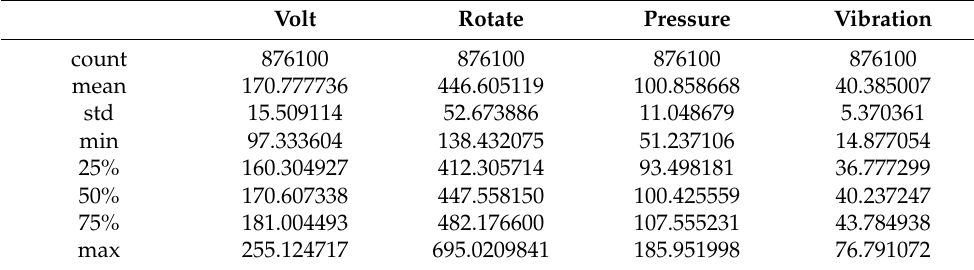
Table 2. Statistical analysis of telemetry data in real